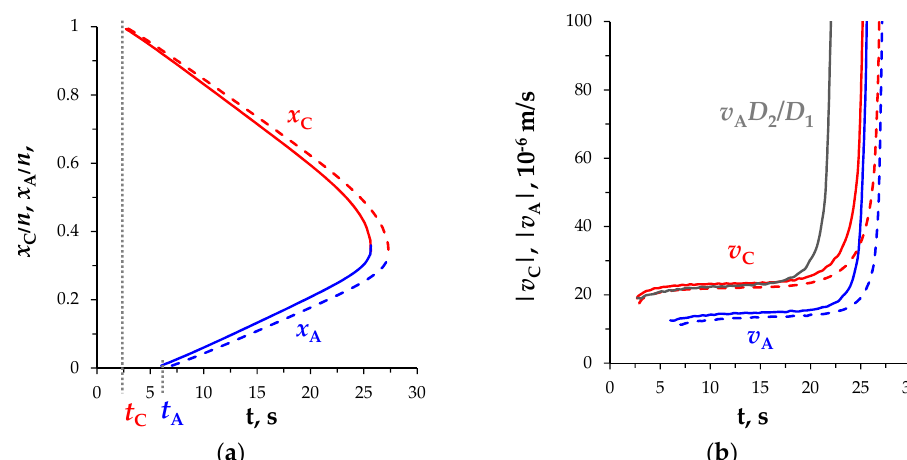
Figure 4 . ( a ) Coordinates of the local extrema, x C and x A ; ( b ) Absolute values of the local extrema velocities, v C and v A . The results for the space-charge extremum for the anion-exchange membrane (AEM) are marked in blue color, for the cation-exchange membrane (CEM)—in red color; t A and t C denote the moments of the appearance of the SCR extrema at the AEM and CEM, respectively; T 2C = T 1A = 0 (solid lines) and T 2C = T 1A = 0.03 (dashed lines), current density i = 2 i lim . Value v A ( t − t A ) D 2 / D 1 is shown in black in Figure ( b ).